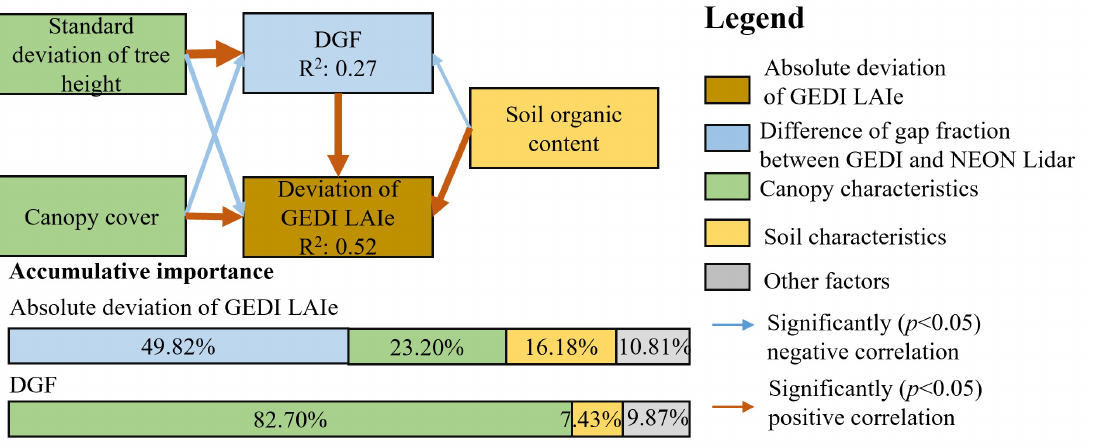
Figure 7. Structural equation model for explaining the direct and indirect effect of factors on the absolute deviation of GEDI LAIe. Different colored boxes represented categories of factors (see Table 1). Light blue and brown arrows show a significant negative and positive correlation between factors, respectively. The R 2 and relative importance were calculated by IMG. Other factors included the characteristics of topographic slope and sensor system